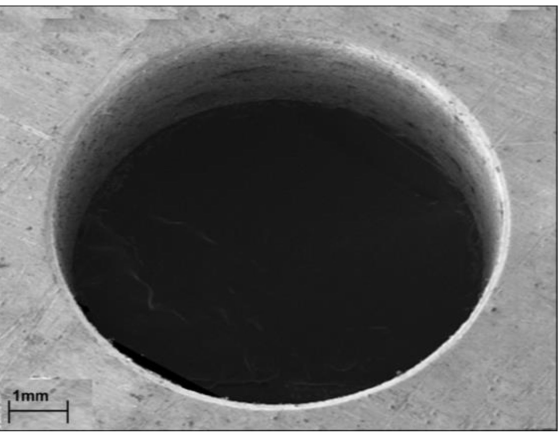
Figure 8. SEM images of mesohole fabricated by spark-erosion drilling (SED)